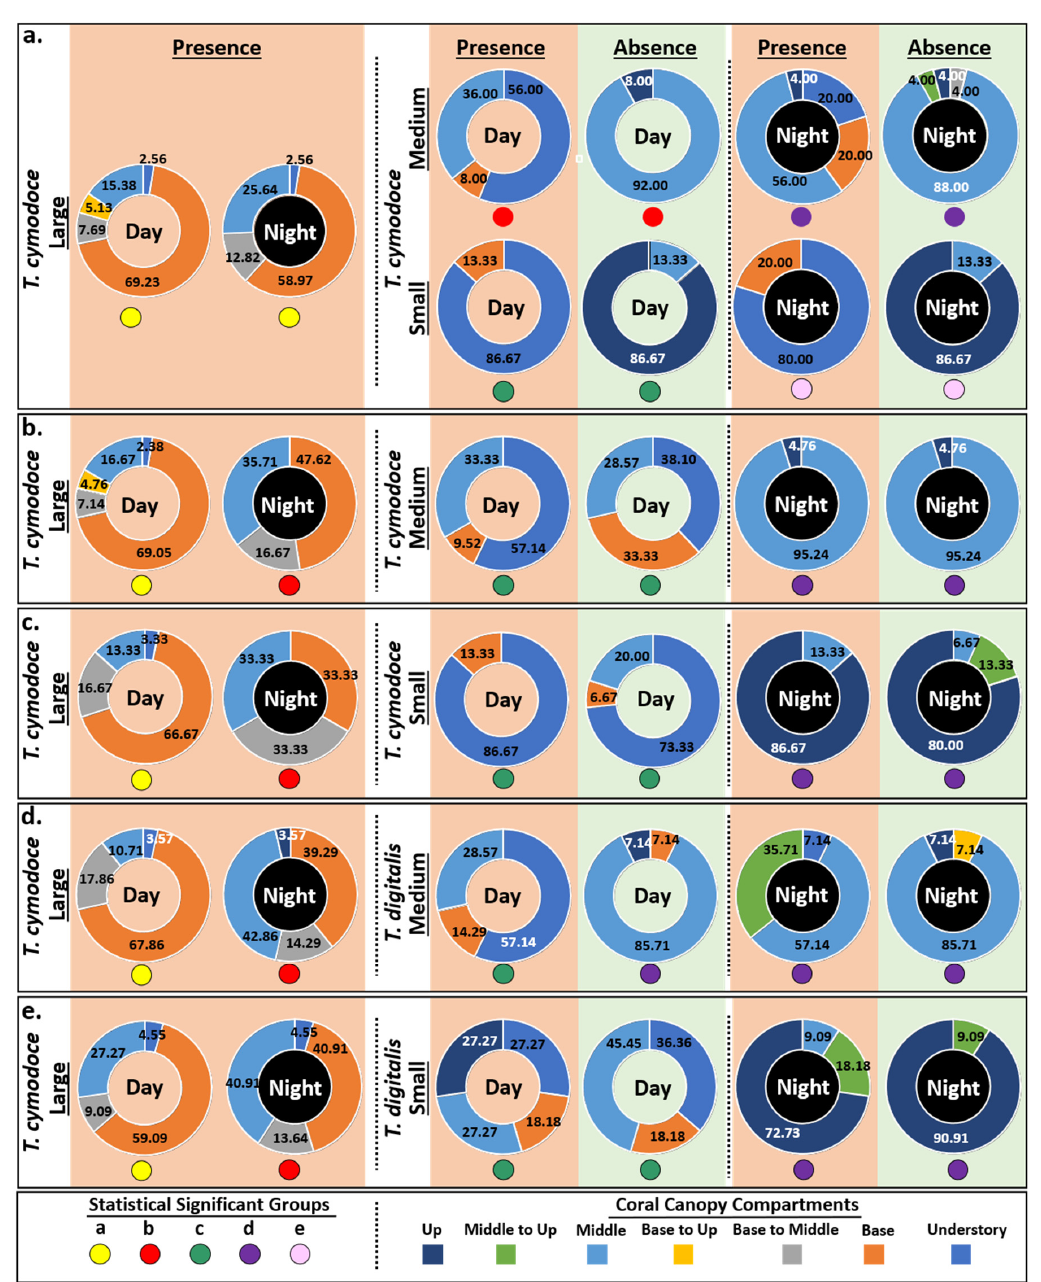
Figure 4. Day and night distribution patterns among Stylophora pistillata canopy compartments of different Trapezia body sizes with the presence or the absence of large Trapezia cymodoce . ( a ) T. cymo ‐ doce medium and small; ( b ) T. cymodoce medium; ( c ) T. cymodoce small; ( d ) Trapezia digitalis medium; ( e ) T. digitalis small. Color dots indicate significantly different groups (pairwise permutation MANOVA; Supplementary Tables S11–S30).